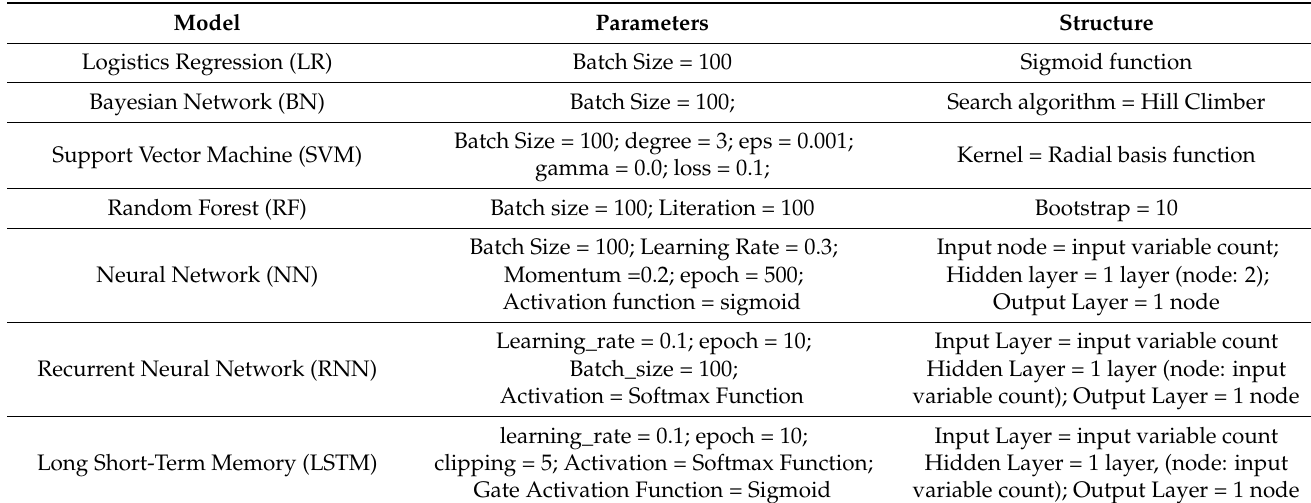
Table 3. Parameters of the ML models.